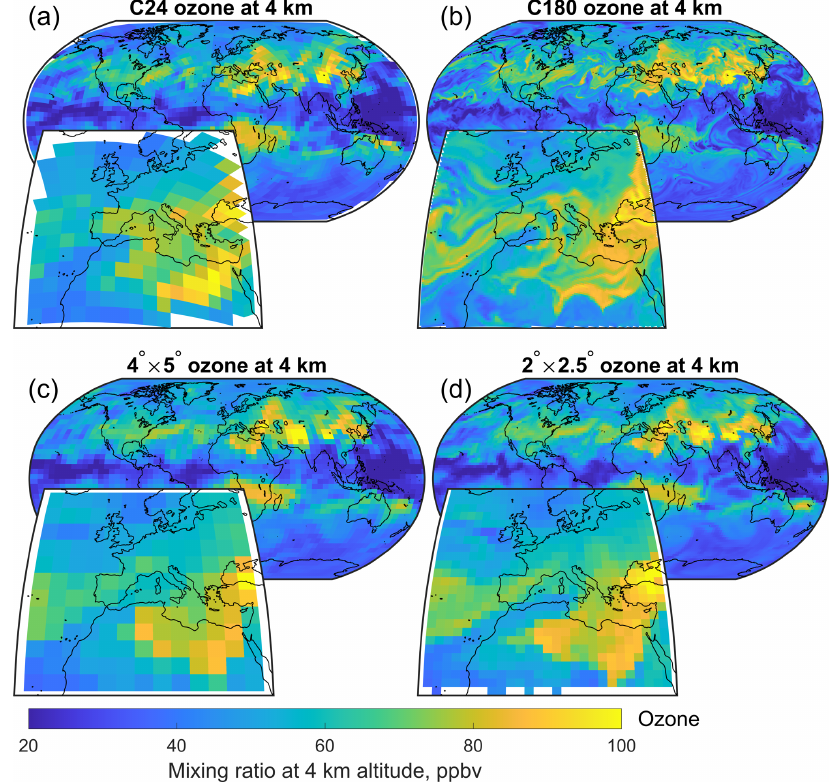
Figure 5. Simulated ozone concentrations at 4km altitude for 23:00UTC on 31 July 2016 after 1 month of initialization. The upper panels show model output from GCHP simulations at C24 (a) and C180 (b) , while panels (c) and (d) show model output from GCC simulations at 4 ◦ × 5 ◦ and 2 ◦ × 2 . 5 ◦ . Calculated values in some regions exceed the displayed limits. Zoom panels are also shown for